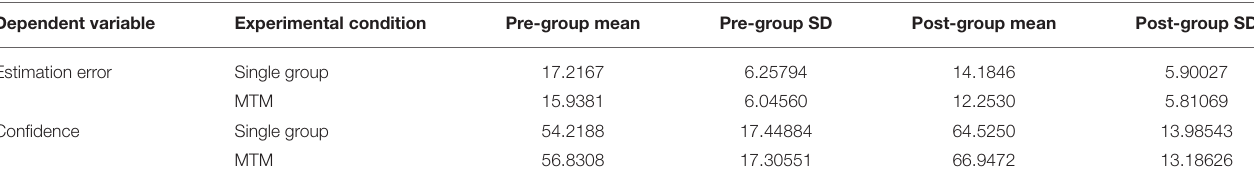
TABLE 2 | Means and standard deviations (SD) for estimation errors and